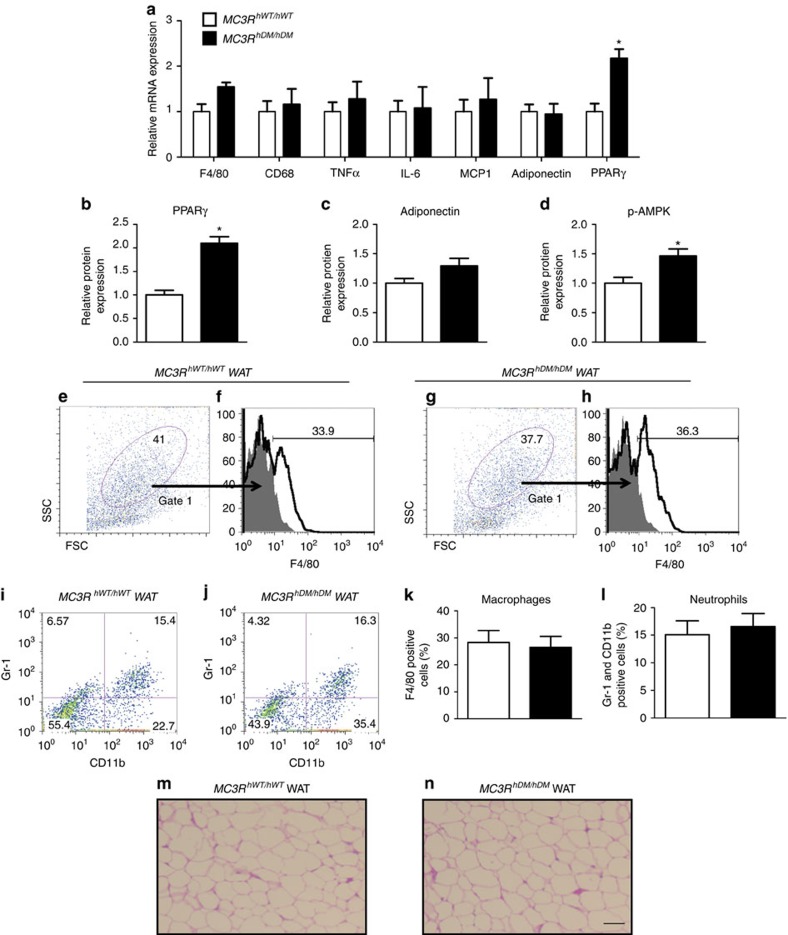
Maintained adipose tissue function in MC3RhDM/hDM mice.Gonadal fat was isolated from fasted female mice fed a high-fat diet for (a) quantitative real-time PCR (MC3RhWT/hWT
n=5; MC3RhDM/hDM
n=8/group), (b–d) western blotting analysis (MC3RhWT/hWT
n=5; MC3RhDM/hDM
n=4), and (e–l) FACS analysis (MC3RhWT/hWT
n=4; MC3RhDM/hDM
n=5) in MC3RhWT/hWT (open bars) and MC3RhDM/hDM (closed bars) mice. (a) The expression levels of genes related to macrophage infiltration, inflammation and adipose tissue metabolism were normalized for β-actin expression. Western protein expression results for (b) peroxisome proliferator-activated receptor gamma (PPARγ), (c) adiponectin and (d) phosphospecific 5′-adenosine monophosphate-activated protein kinase (p-AMPK), divided by glyceraldehyde 3-phosphate dehydrogenase (GAPDH) expression and normalized relative to average for MC3RhWT/hWT. The stromal vascular fraction was isolated from gonadal fat (∼2 g) from MC3RhWT/hWT and MC3RhDM/hDMmice. For detecting macrophages by flow cytometry, a gating strategy was used to enrich samples from MC3RhWT/hWT and MC3RhDM/hDMmice for adipose tissue macrophages by selecting cells in the gate 1 area (e,g). The gate 1 area was stained with a F4/80 antibody (f and h) and the dot plots depict forward scatter (FSC) and side scatter (SSC) (left). For detecting neutrophils, whole cells (non-gated) were stained with CD11b and Gr-1 (i,j). Bar graphs show the average values±s.e.m. for percentage of cells in the stromal vascular fraction that were (k) macrophages and (l) neutrophils. *P<0.05 MC3RhDM/hDMversus MC3RhWT/hWT. (m,n) Haematoxylin and eosin stained sections showed no apparent differences in adipocyte morphology between groups. Groups were compared by Student's t-tests (two-tailed) (a–d and k–i). Scale bar, 100 μm. Data are represented as mean±s.e.m. for a-d, k, and l. FACS, fluorescence-activated cell sorting